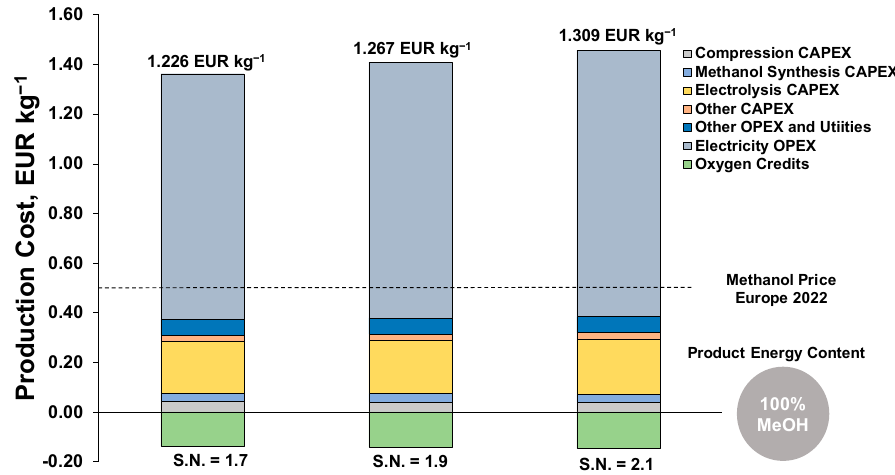
gases could decrease the production costs by 19.9% and 90% recycling by 43.6%, resulting